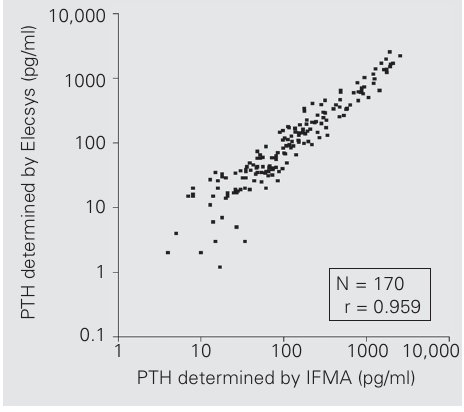
Figure 1. Correlation between the results of rapid intraoperative in- tact parathyroid hormone (PTH) determined by the Elecsys immu- nochemiluminometric assay and by a standard immunofluorimetric assay (IFMA). N = number of pa- tients; r = correlation